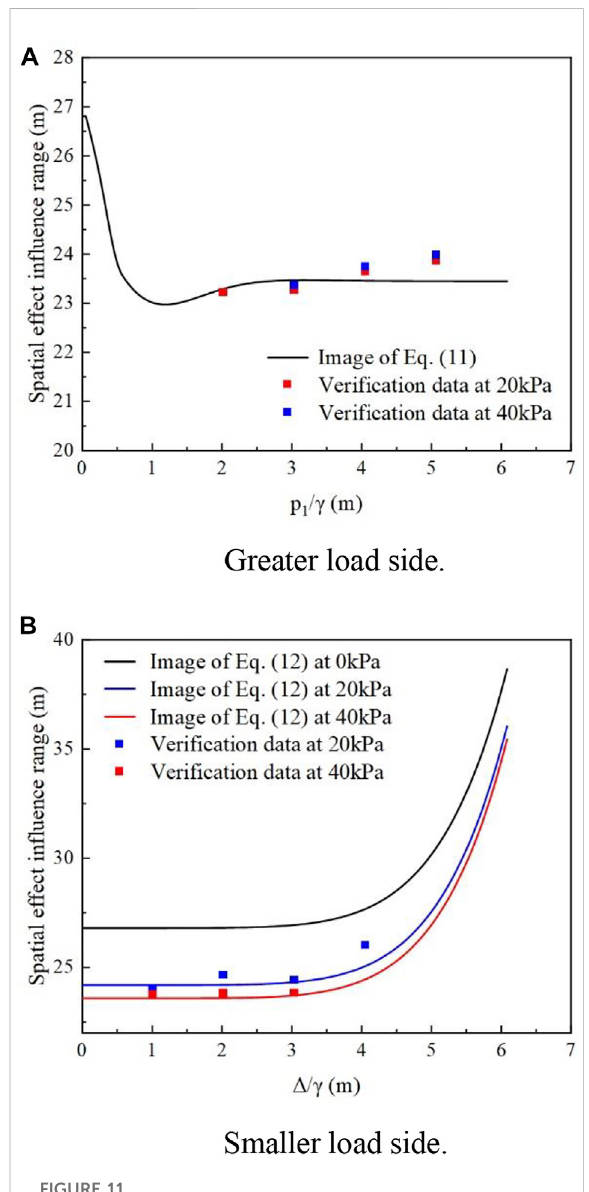
FIGURE 11 Images and validation data of the equation for the in fl uence range of spatial effects under asymmetric loads. (A) Greater load side. (B) smaller load